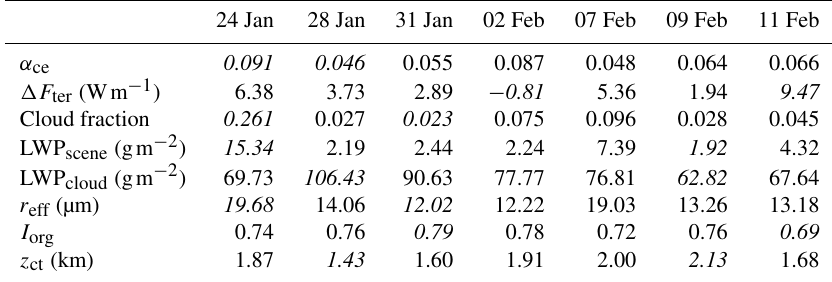
Figure 2. Histograms of all cloud properties for the subset of EUREC 4 A flights and data used in the analysis. Labeled red bars indicate the mean value. (a) Effect of clouds on albedo. (b) Terrestrial cloud radiative forcing. (c) Cloud fraction. (d) Mean liquid water path for the scene. (e) Mean liquid water path for the clouds. (f) Mean effective radius. (g) Organization index; black bar at 0.5 separates normal and clustered I org values. (h) Mean cloud top height. Table 3. Median values shown in Figs. 3 and 4. The highest and lowest values for each parameter are marked in